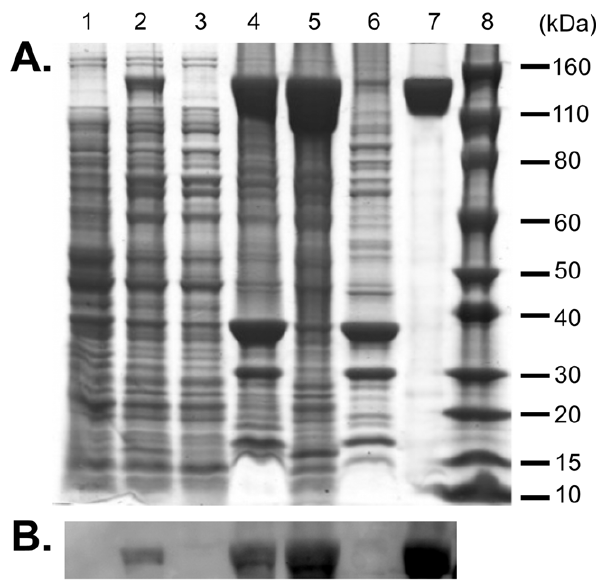
Figure 1. Fractionation and purification of recombinant Zbed4 protein expressed in E.coli cells. A. SDS-PAGE. 50 m g/well of total protein from each fraction obtained in the expression, purification and refolding of Zbed4 were separated by SDS-PAGE on 4–12% Bis-Tris gels and stained with Coomassie R-250. Lane 1, whole E. coli lysate before IPTG induction. Lane 2, whole cell lysate after 6 h induction by IPTG. Lane 3, soluble proteins of E. coli cell lysate in HEPES buffer containing 1% Triton X100 and other components (see Materials and Methods), after passing through a French pressure chamber and centrifugation at 150,000 g. Lane 4 , insoluble material (inclusion bodies) of lysate. Lane 5 , solubilized inclusion bodies in 6 M Gu-HCl buffer 1, after centrifugation at 150,000 g. Lane 6 , insoluble fraction of inclusion bodies. Lane 7 , Zbed4 purified using BD Talon Co 2 + -activated affinity chromatography, after the refolding procedure and concentration. Lane 8 , Novex Sharp (Invitrogen) standard protein markers. B. Detection of Zbed4 on Western blots using Penta His antibodies. Following SDS-PAGE, the separated proteins of each fraction were transferred to PVDF membranes and after blocking and incubation with Penta His antibodies conjugated with horseradish peroxidase, Zbed4 was visualized with the ECL Substrate of the Fast Western blot